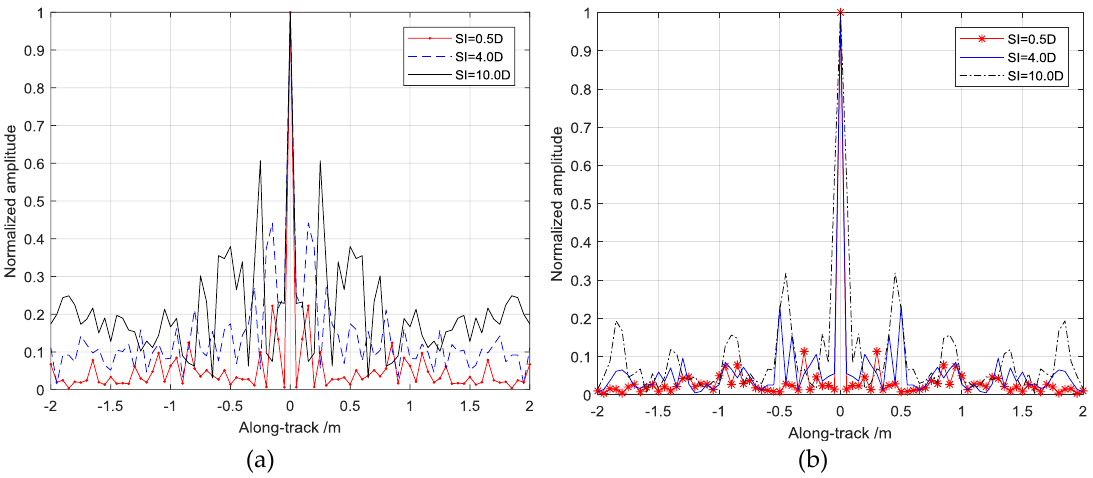
Figure 4. Side lobe comparison between single-line and multi-line receiving array systems. ( a ) Side lobe of single-line array; and ( b ) multi-line array at different sampling intervals.